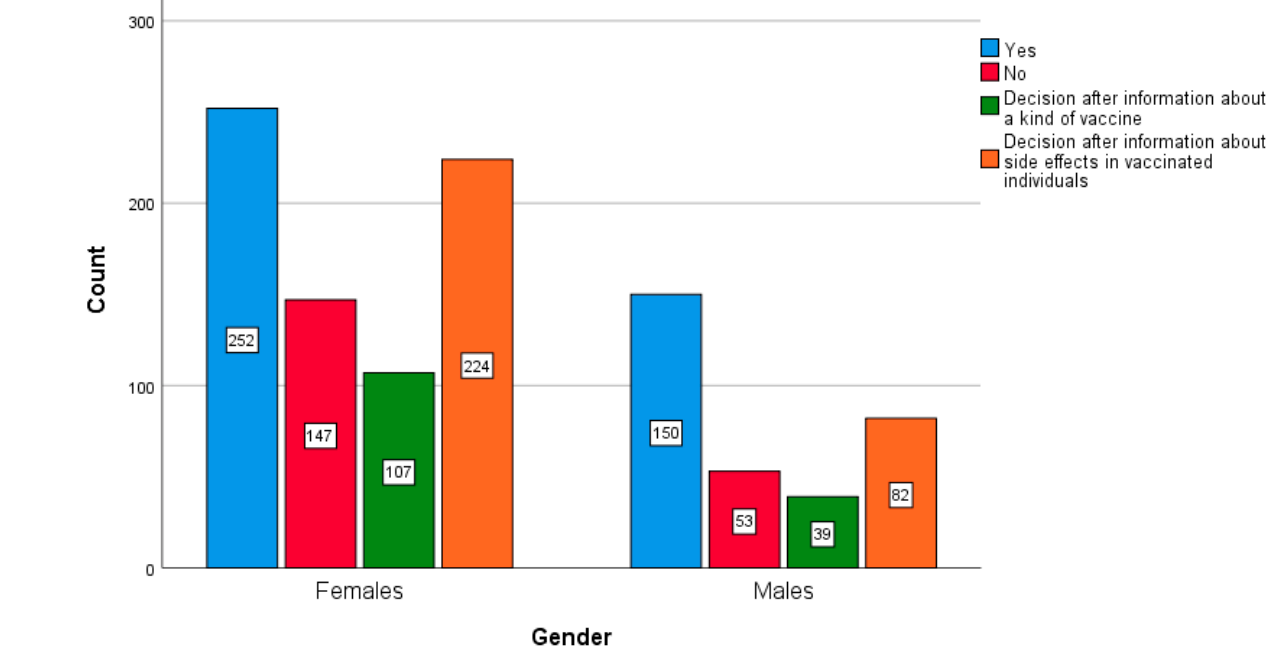
Figure 5. Gender and declared attitude towards the COVID-19 vaccination in the group of non-medical professions.